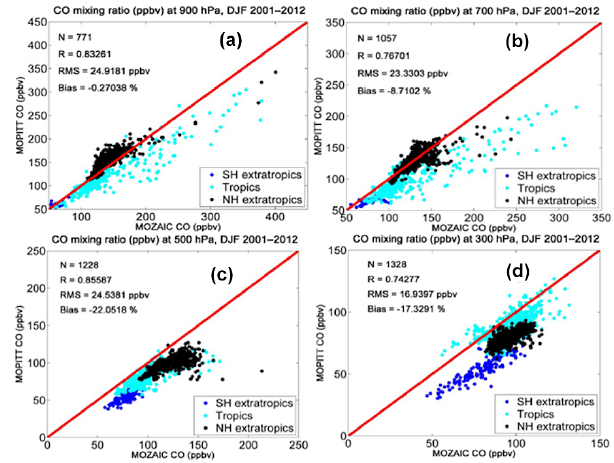
Figure 9. Comparison results for DJF (December, January, Febru- ary) 2001–2012. MOPITT CO retrievals at 900, 700, 500, and 300hPa are plotted against trajectory-mapped MOZAIC-IAGOS CO climatology profiles that have been transformed using the MO- PITT averaging kernels and a priori data. The red line is the 1 : 1 line, N denotes the total number of data points, R is the correla- tion coefficient, RMS is root mean square error in ppbv, and Bias is the relative bias between them in percent. In each panel, the dif- ferent color dots group different latitude bands: 23.5–66.5 ◦ S (SH extratropics), 23.5 ◦ S–23.5 ◦ N (tropics), and 23.5–66.5 ◦ N (NH ex- tratropics).